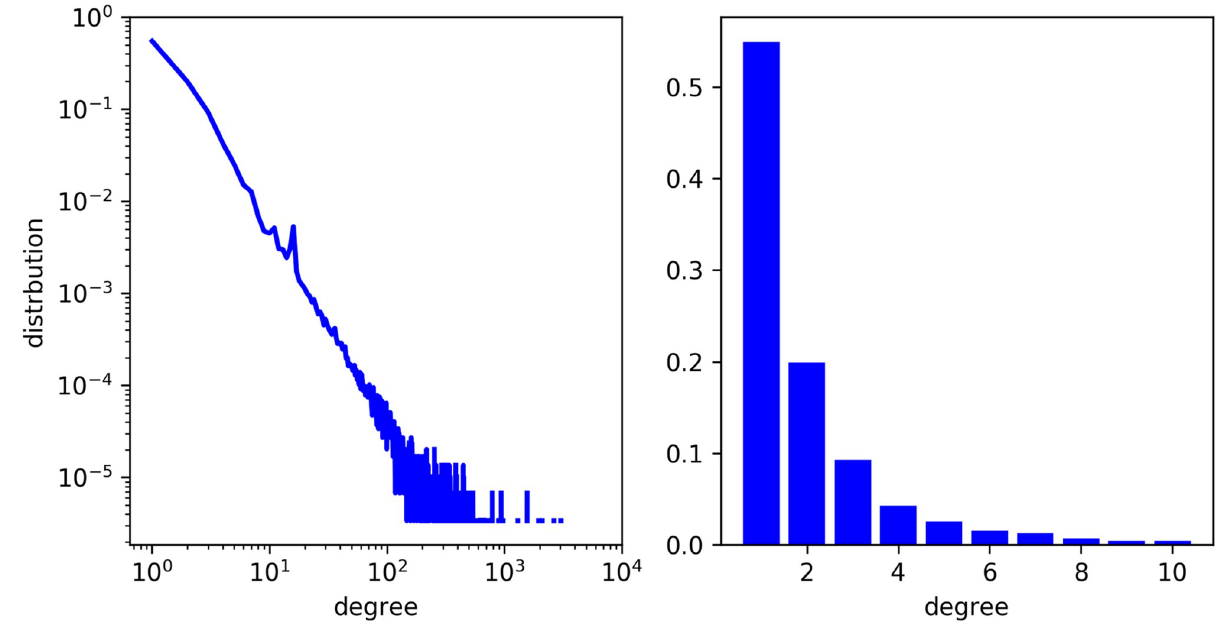
Fig 1. Degree distribution of